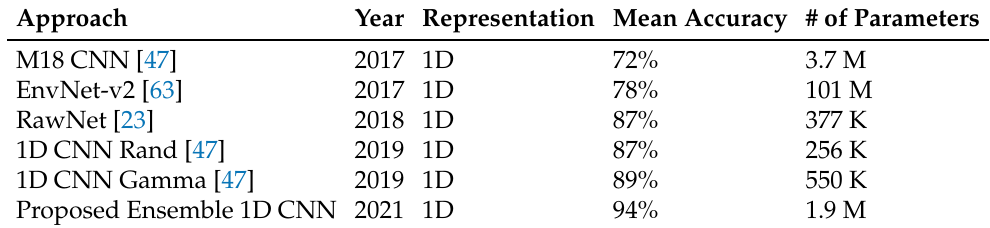
Table 7. Mean accuracy of different approaches on the UrbanSound8k dataset.